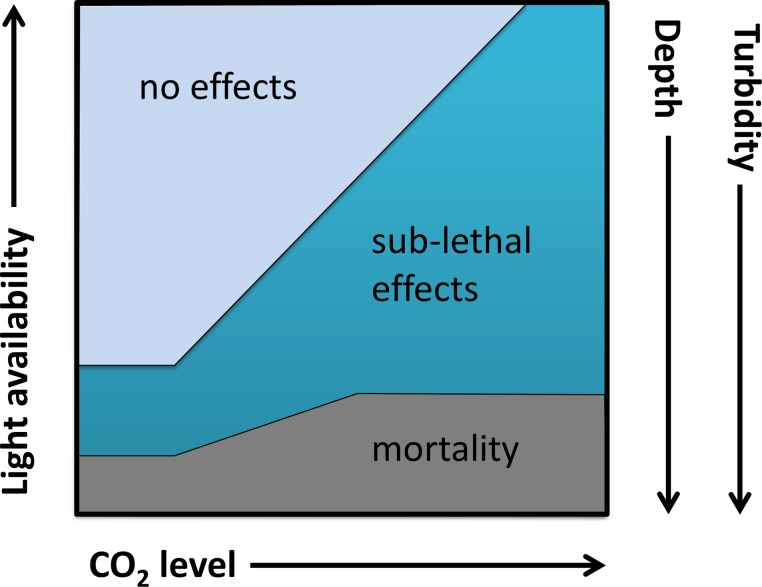
Conceptual diagram showing the relationship between CO2 and light availability.Seawater CO2 level (ocean acidification) and light availability influence the likelihood of sub-lethal and lethal effects on juvenile giant clams. This diagram is based on experimental data and is therefore for the range of light levels investigated this study only (PAR 35–304 μmol photons m-2 s-1).